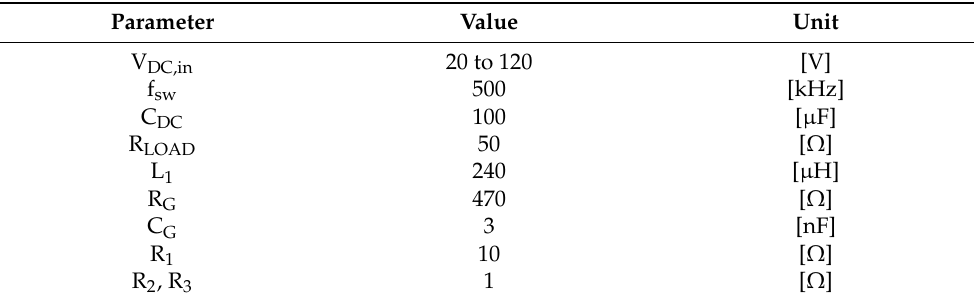
Table 1. Main parameters of the DCDC boost converter used for testing the DUT_S and depicted in Figure 10. Parameter Value Unit